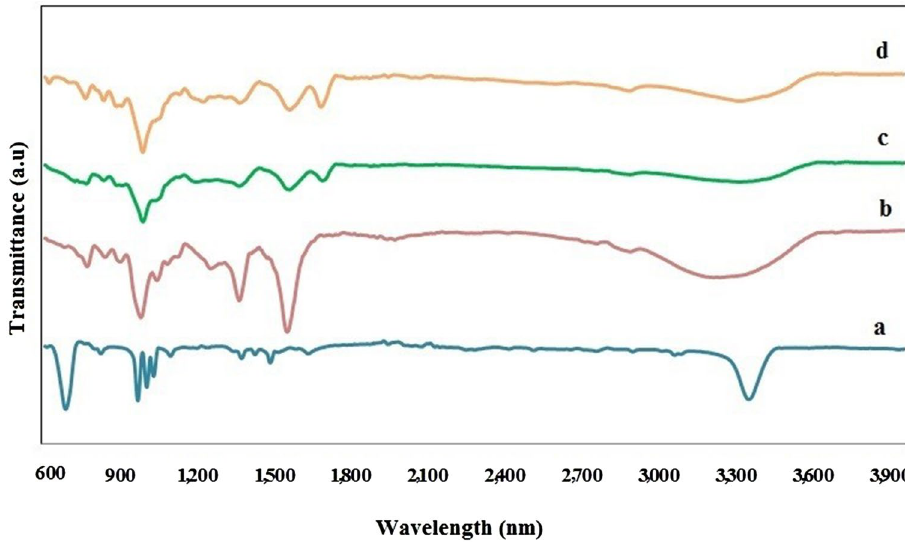
Figure 2. FTIR spectra of ( a ) pyrrole, ( b ) alginate, ( c ) alginate 3% + 1 cc pyrrole, ( d ) alginate 3% + 2 cc